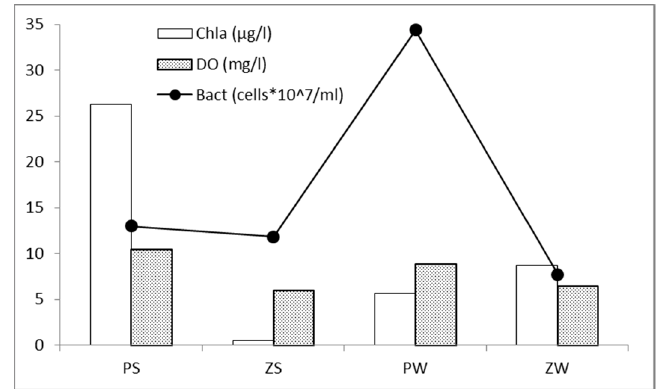
Figure 1. Chlorophyll-a (Chla), dissolved oxygen (DO) and bacterial abundance in Pamvotis (P) and Ziros (Z) Lakes in summer (S) and winter (W).